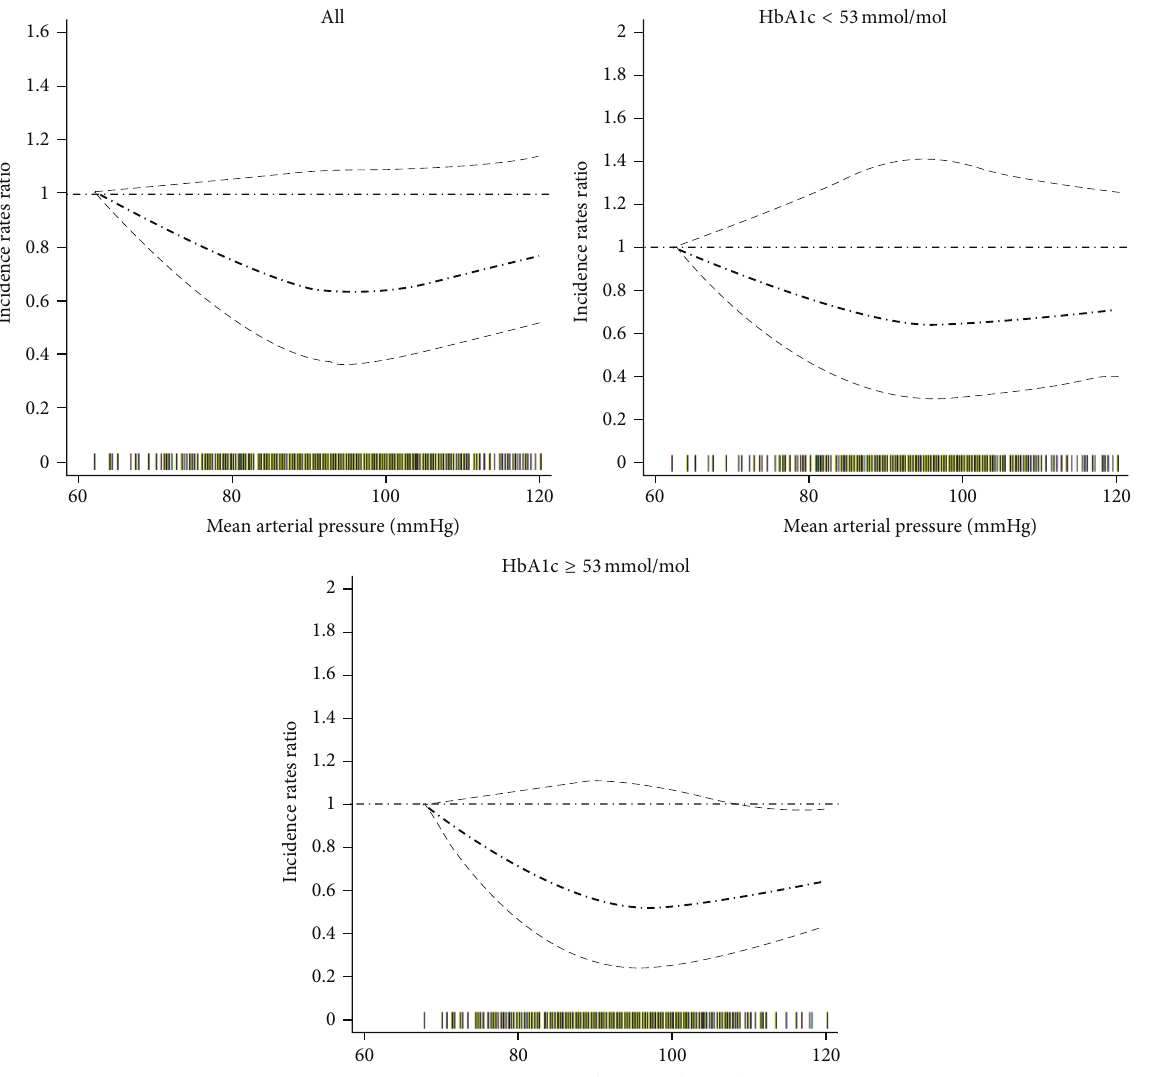
Figure 2: Relationship between mean arterial pressure and cardiovascular hospital admission: analysis in data rich range. Adjusted for prevalent recorded history of cardiovascular/cerebrovascular disease, duration of diabetes registration in GP practices, body mass index, triglyceride, total cholesterol, low density lipoprotein, high density lipoprotein, estimated glomerular filtration rate, smoking status, lipid- lowering treatment, aspirin treatment, and pulse pressure. The thick dash-dot line indicates the incidence rate ratio and the thin dash line indicates the 95% confidence interval. The rag plot (bars on the 𝑥 -axis) presents the mean arterial pressure